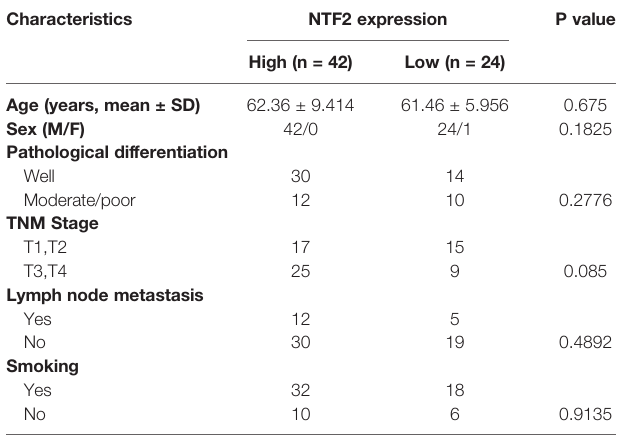
TABLE 2 | Correlation between NTF2 expression and the clinicopathological features in 66 HNSCC samples.